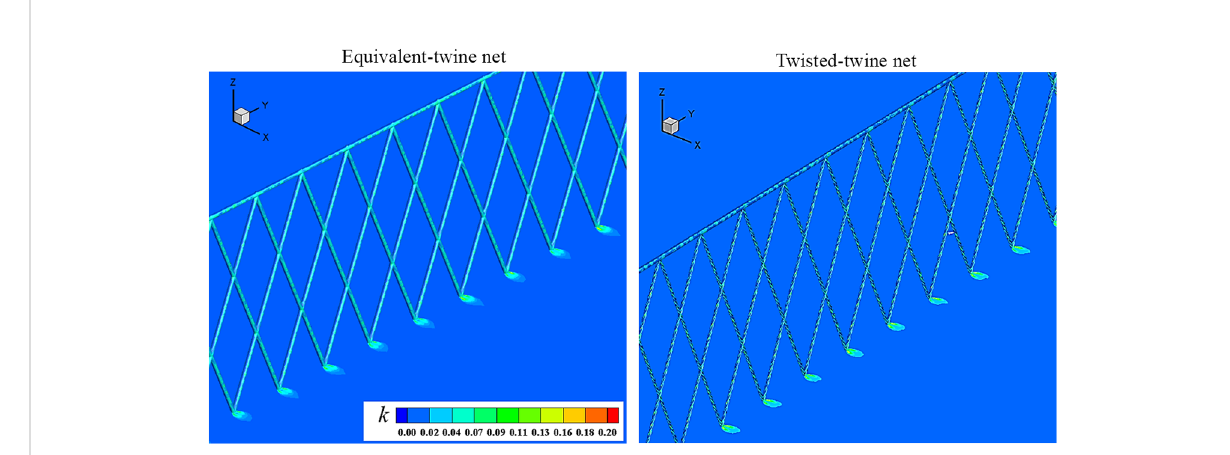
FIGURE 11 Comparison of the turbulent kinetic energy contours by the URANS model at AOA = 90°.